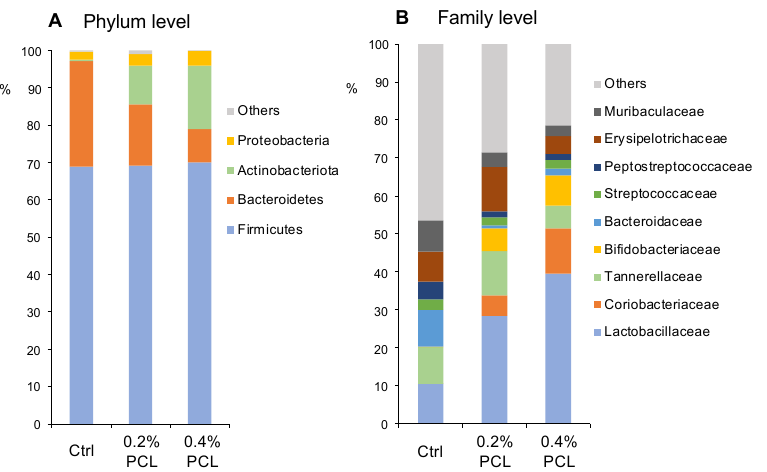
Figure 3. Effects of supplemental PCL on cecal microbiota composition (average, % of total bacteria) at the phylum ( A ) and family ( B ) levels.